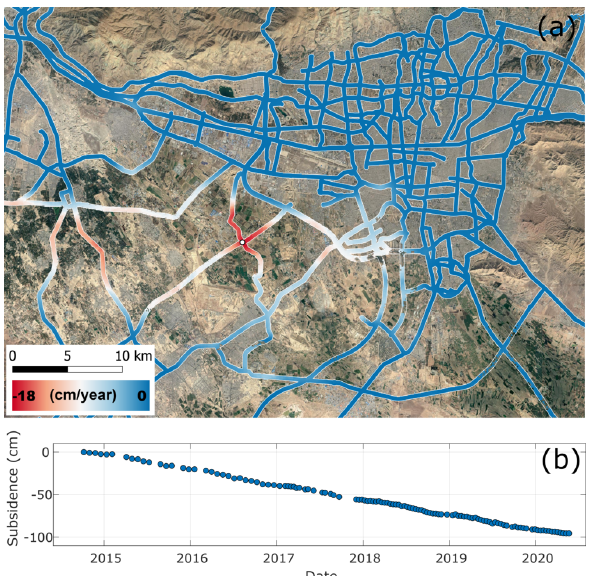
Figure 6. High-resolution analysis of subsidence for monitoring roads and highways in Tehran. (a) average rate of subsidence along major roads and highways. (b) Time series of subsidence for a point, at the intersection of Tehran-Saveh freeway and Ahmadabad-Mostofi road, indicated by white circle in (a). Background imagery for (a) Google Earth Landsat/Copernicus, Map data